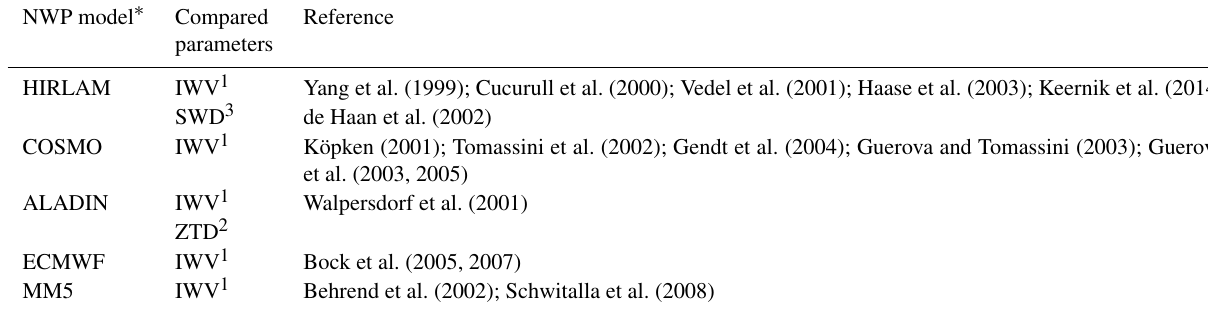
Table 4. Comparison of GNSS tropospheric products and NWP models in